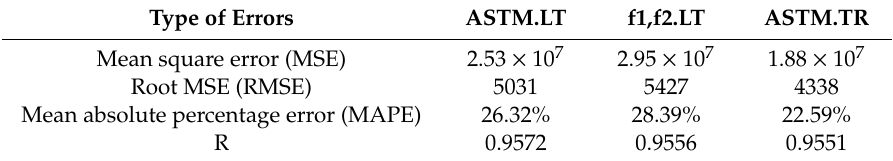
Table 5. Comparison of errors and correlations between Ei and dynamic elastic moduli ( Eds ). Type of Errors ASTM.LT